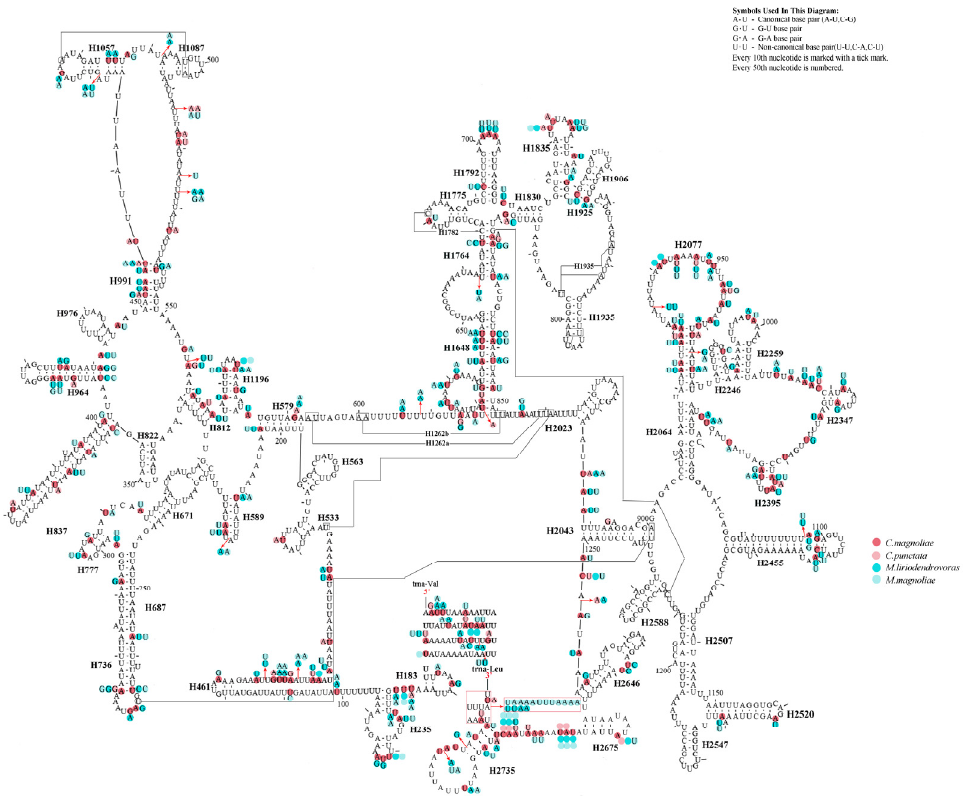
Figure 4. Predicted rrnS secondary structure in the Cladiucha mitochondrial genome. The numbering of helices follows Gillespie et al. [52]. Roman numerals refer to domain names. Tertiary inter-actions and base triples are connected by continuous lines. C. mag- noliae as a basemap and base change among Cladiucha species are presented in circles with red ( C. magnoliae ) and pink ( C. punctata ) colors.